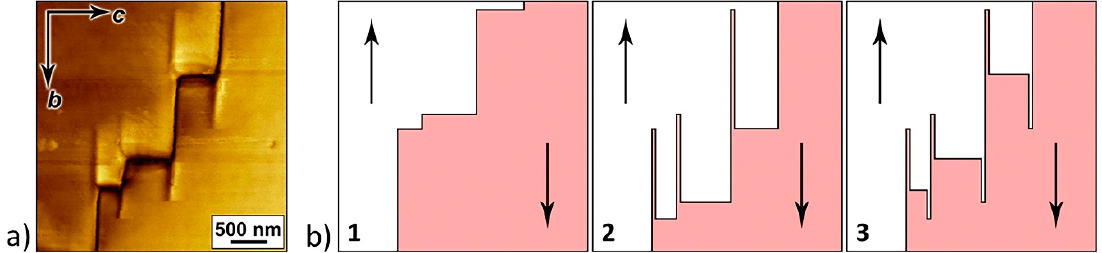
Figure 7. Nanodomains on charged domain walls. ( a ) Lateral PFM image of nanodomains on step-like domain walls. ( b ) Scheme of nanodomain formation as a result of cyclic motion of macrosteps: ( 1 ) Initial structure and displacements of charged domain walls ( 2 ) during heating and ( 3 ) during cooling. Arrows b and c show the directions of crystal axis. The arrows indicate the spontaneous polarization directions.